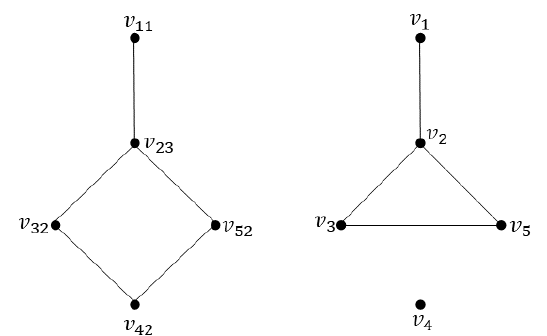
Figure 1. The graphs G and G δ